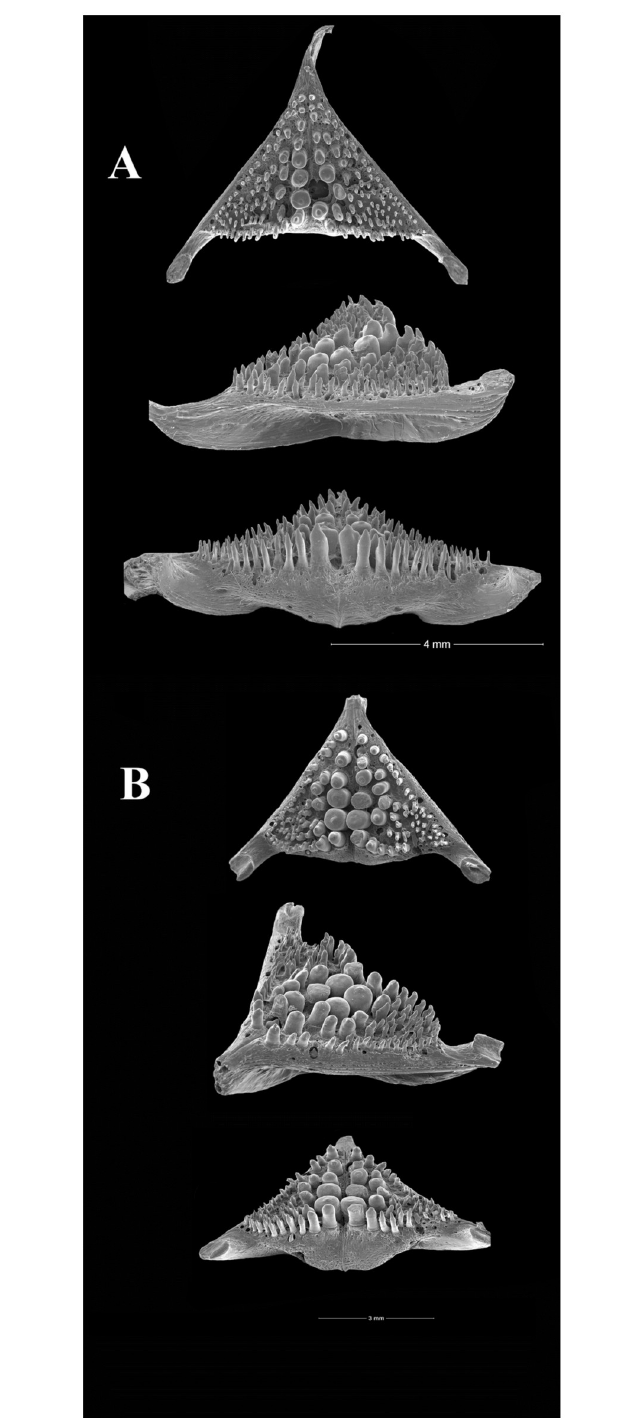
Fig 20. Australoheros acaroides. SEM image of the lower pharyngeal tooth plate. A. occlusal, approximately lateral and posterior aspect from MCP 9812, 63.3 mm SL., 63.3 mm SL; Rio Grande do Sul: Tramandai: Terra de Areia: Rio Sanga Funda on road BR 101; B. occlusal, latero-occlusal and caudal aspect from MCP 26548, 67.0 mm; Brazil: Rio Grande do Sul: Nova Palma: Rio Jacuı´drainage: Arroio Caembora´ close to Caembora´. MCP 26548, 67.0 mm.; In Tramandai specimen width 54% of length; dentigerous area width 84% of dentigerous area length. Anterior teeth subconical, slightly retrorse; 5–5 wide teeth in anteroposterior row along median suture, apex tuberculate with a minor